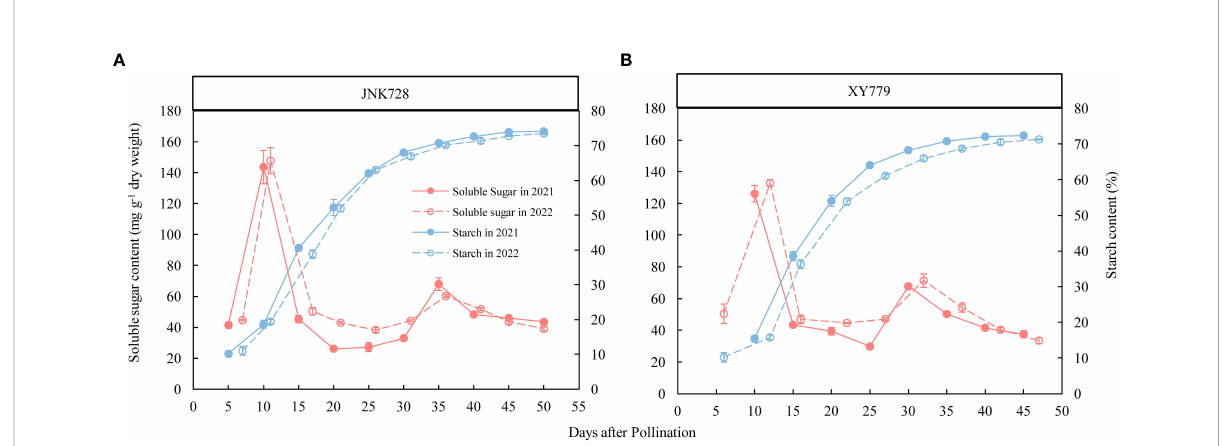
FIGURE 9 Soluble sugar and starch contents of (A) JNK728 and (B) XY779 grains at the grain fi lling stage in 2021 and 2022. The values are presented as means ± SE